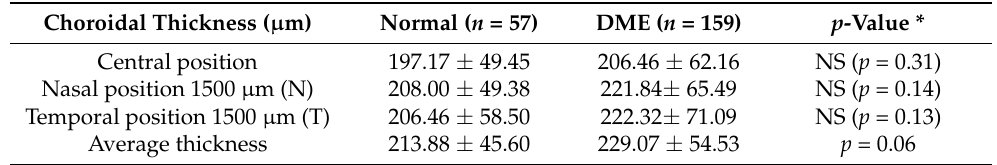
Table 3. Comparison of choroidal thickness measurements (using the automated method) between normal group and diabetic macular edema (DME) groups at three locations.